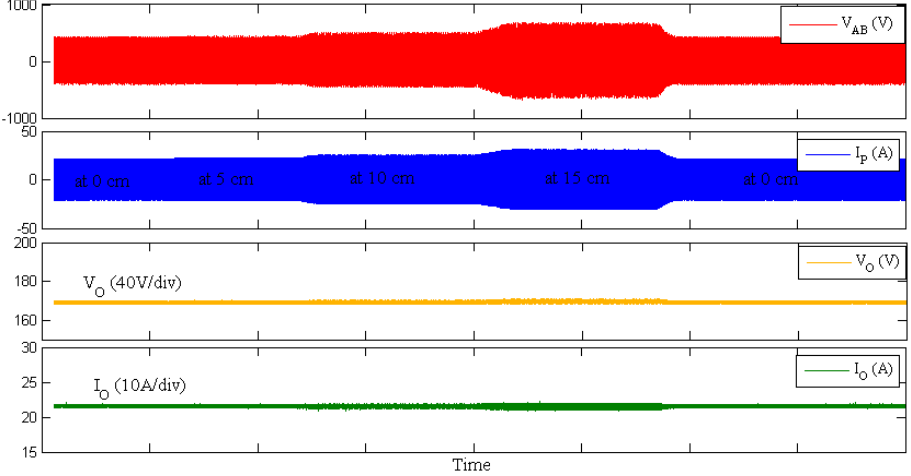
Figure 14. Experimental results for change in mutual coupling.